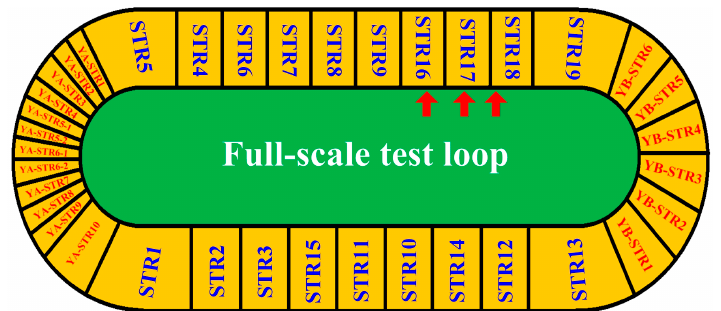
Figure 11. The full-scale test loop in the highway proving ground of Ministry of Transport of China. The red arrows indicate the drilling positions of field cores.